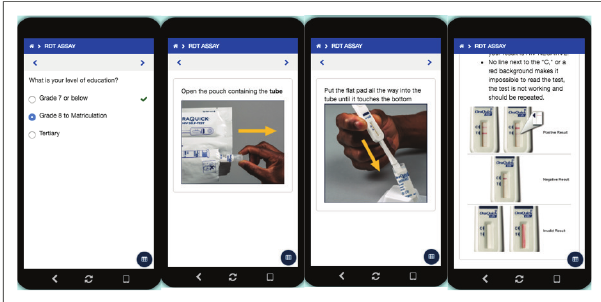
FIGURE 1: Screenshots of the Aspect TM HIV-self-testing mobile app.